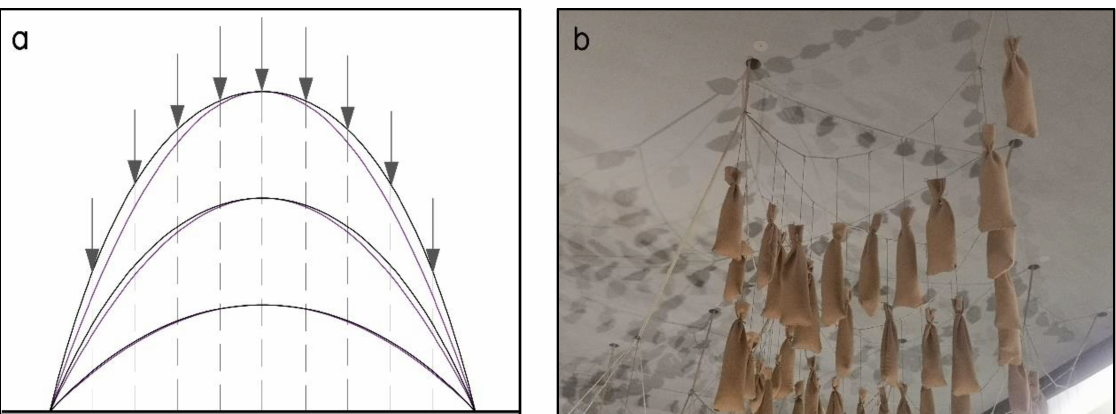
Figure 3. Catenary curves: ( a ) comparison of the curvature of a parabola (purple curves) and catenary (black curves); ( b ) catenary curves in the catenary model in Sagrada Familia, Barcelona (authors compilation).